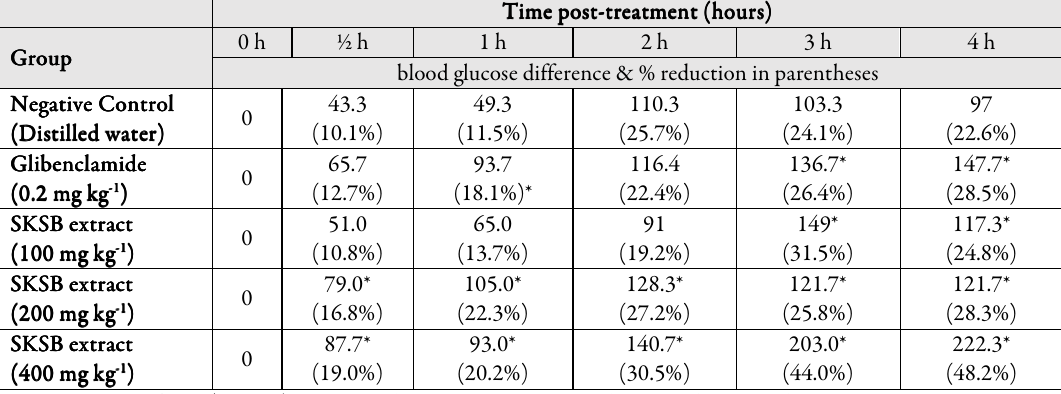
Table Table Table Table 4444. . . . Calculated blood glucose difference and percentage reduction in Streptozotocin-induced diabetic rats post treatment with SKSB